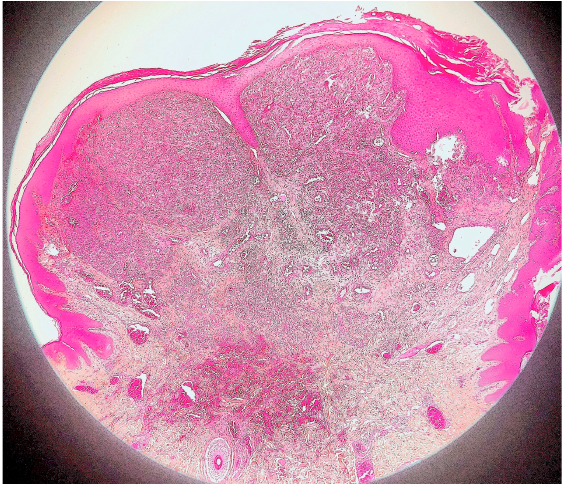
Figure 2. Scanning view of the lesion: well-demarcated, dermal nodule, surrounded by an epidermal collarette (haematoxylin–eosin–saffron stain).